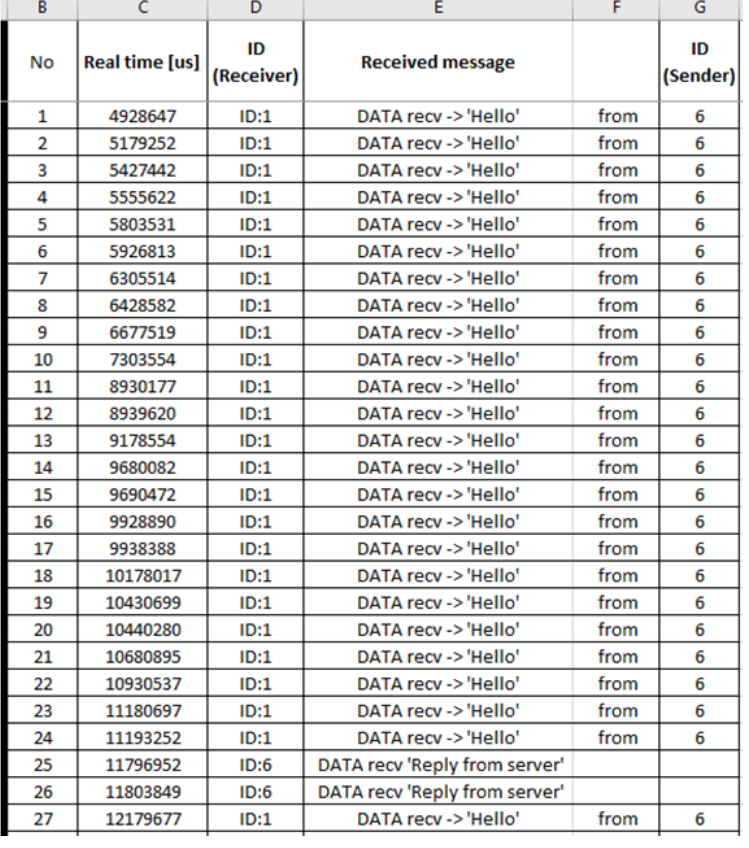
Figure 30. Malicious “recv.csv” — 1 to 27 records.